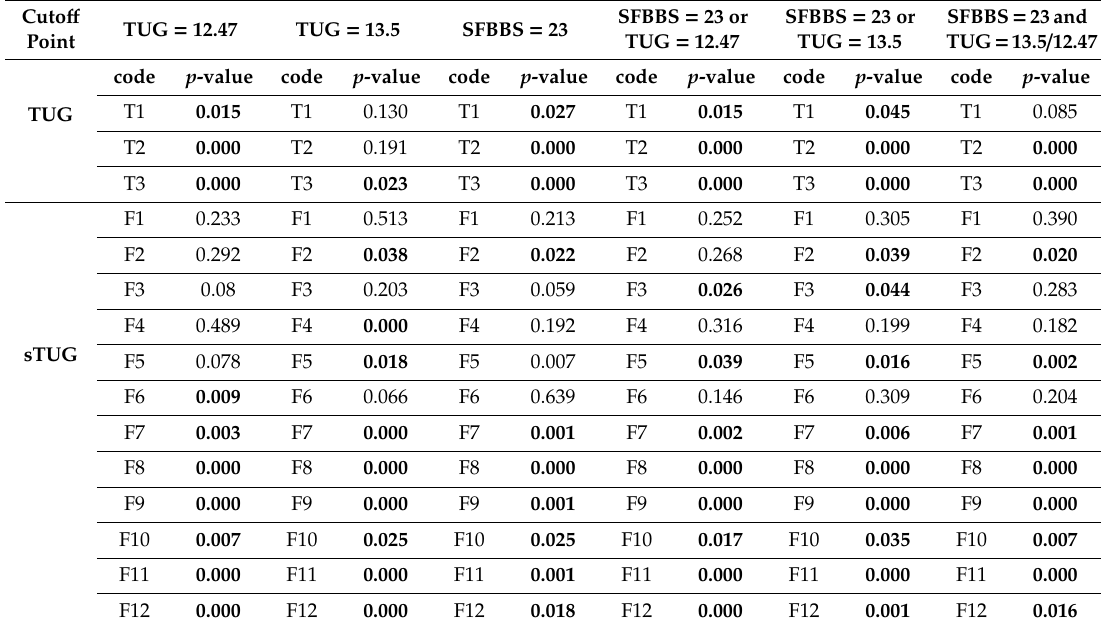
Table 2. The results for the cuto ff point of the TUG and SFBBS intersection or convergence.